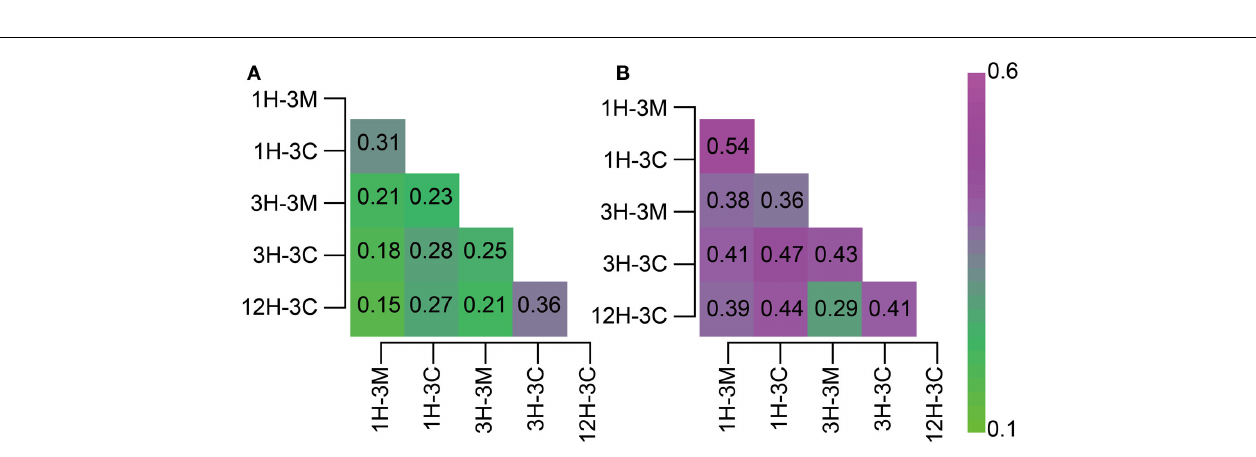
FIGURE 3 | Heat map matrix of Sørenson index values among 16S rRNA gene-tagged sequence libraries. The index score indicates the similarity between two (A) bacterial or (B) archaeal communities.